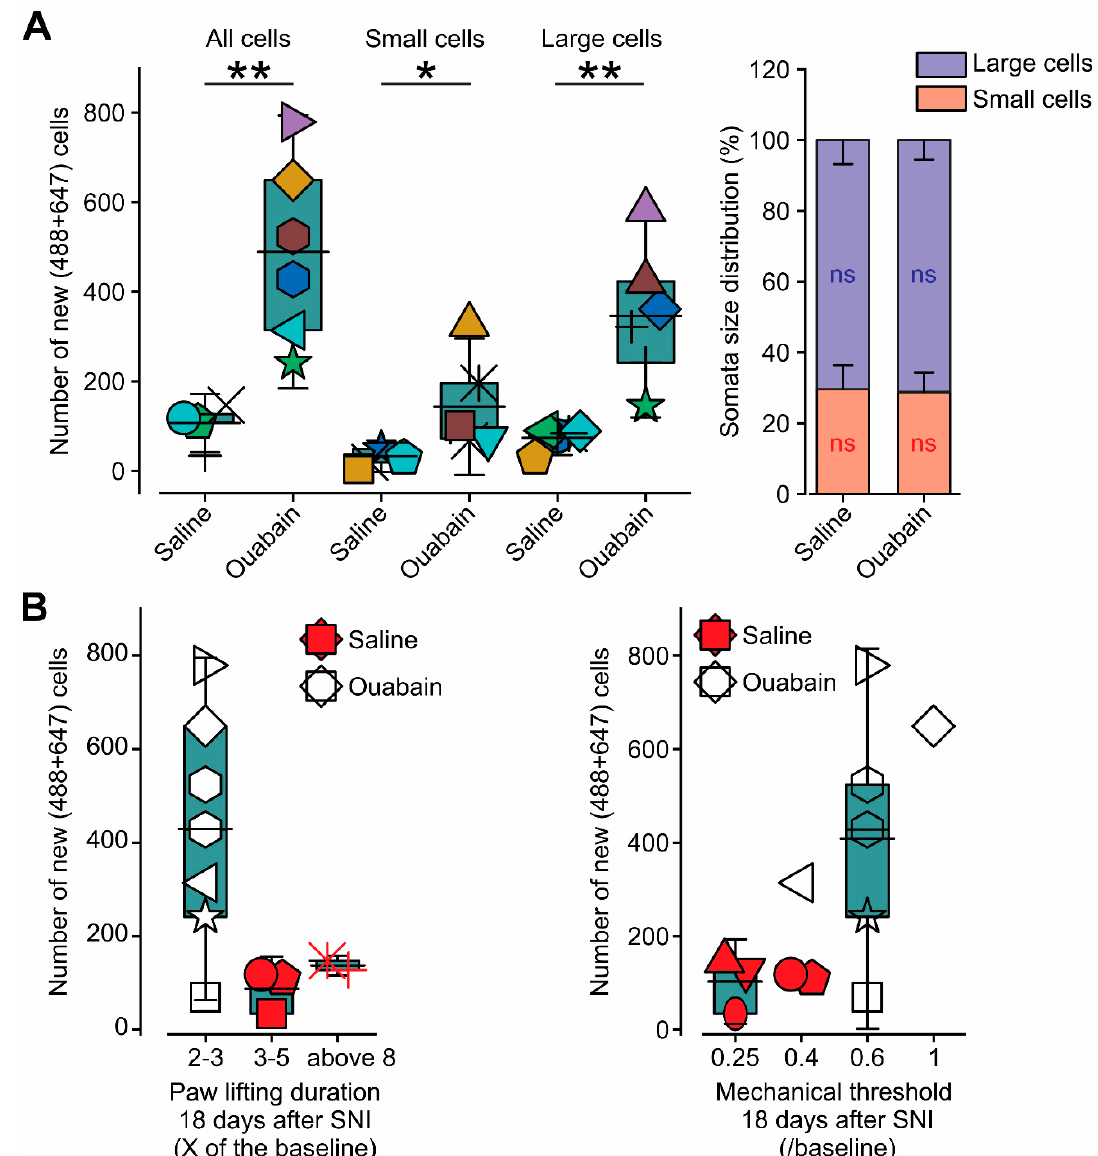
Figure 6. Ouabain promotes reinnervation of the denervated skin areas. ( A ) Left, Box plots and individual values of the total number of L 3-6 DRG somata labeled with AF488 or AF647; a number of small cells and number of large cells labeled with AF488 or AF647, 18 days after SNI in animals treated with ouabain and saline. ** p < 0.01; * p < 0.05; ns—not significant, Student t -test. Box plots presented in the figures depict mean; 25th; 75th percentile and SD. Right, bar graph depicting the distribution (in %) of large (lilac) and small (pink) DRG neurons labeled with AF488 or AF647, 30 days after SNI in animals treated with ouabain and saline (shown in A , left), ns—not significant, comparisons are between the number of cells in animals treated by ouabain and saline. ( B ) Box plots and individual values of the number of DRG somata labeled with AF488 or AF647 in the DRGs extirpated from rats treated with either saline (red symbols) or ouabain (white symbols) 18 days after SNI and plotted according to the level of mechanical hyperalgesia (measured as the duration of paw lifting following pinprick and presented as fold change from the baseline value, left) and mechanical allodynia (measured as VF mechanical threshold and normalized to the baseline value, right). Box plots presented in the figures depict mean; 25th; 75th percentile and